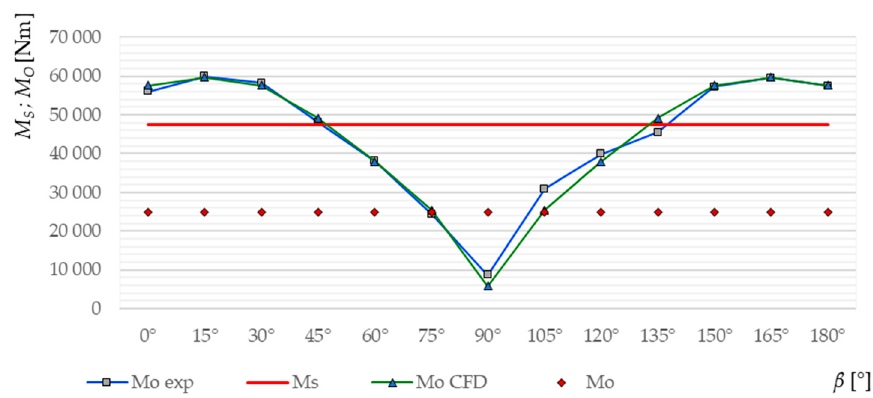
Figure 15. Comparison of the overturning and stabilizing moments received from the experimental and numerical tests with the calculation based on [17] for the wind speed V = 20 m/s (config. 1).